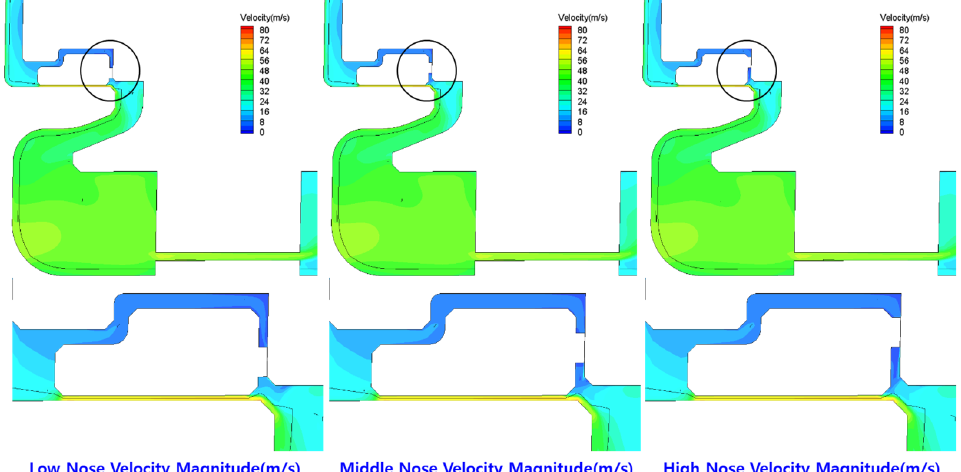
Figure 12. Static pressure (MPa) distributions with change in nose height.